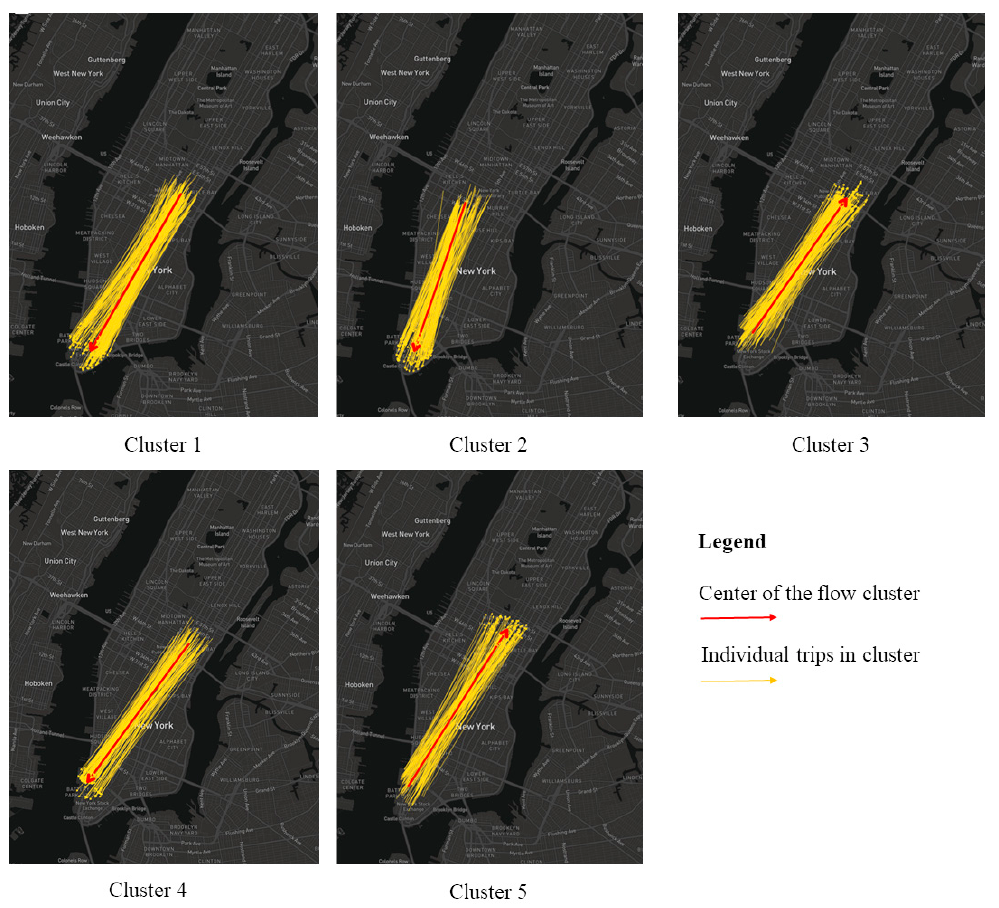
Figure 13. Top five flow clusters discovered by TOCOFC.